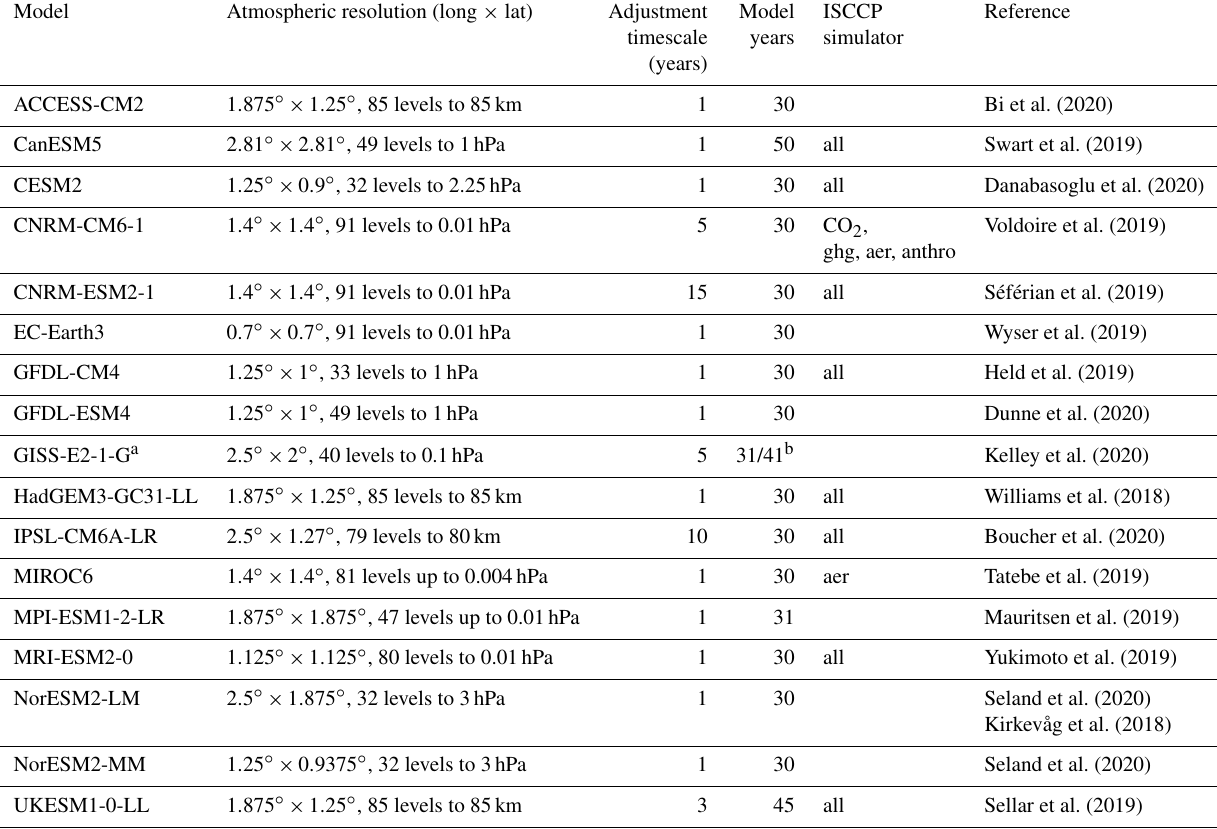
Table 1. Contributing climate models to RFMIP-ERF Tier 1. The adjustment time is based on approximately how long stratospheric tempera- tures take to equilibriate in the 4 × CO 2 experiment (Fig. 2). ISCCP (International Satellite Cloud Climatology Project) simulator diagnostics are indicated where